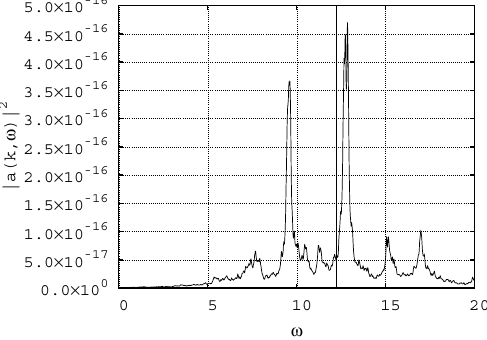
Figure 17. Spectral line of the harmonic k = (0, 50). The conden- sate was present.